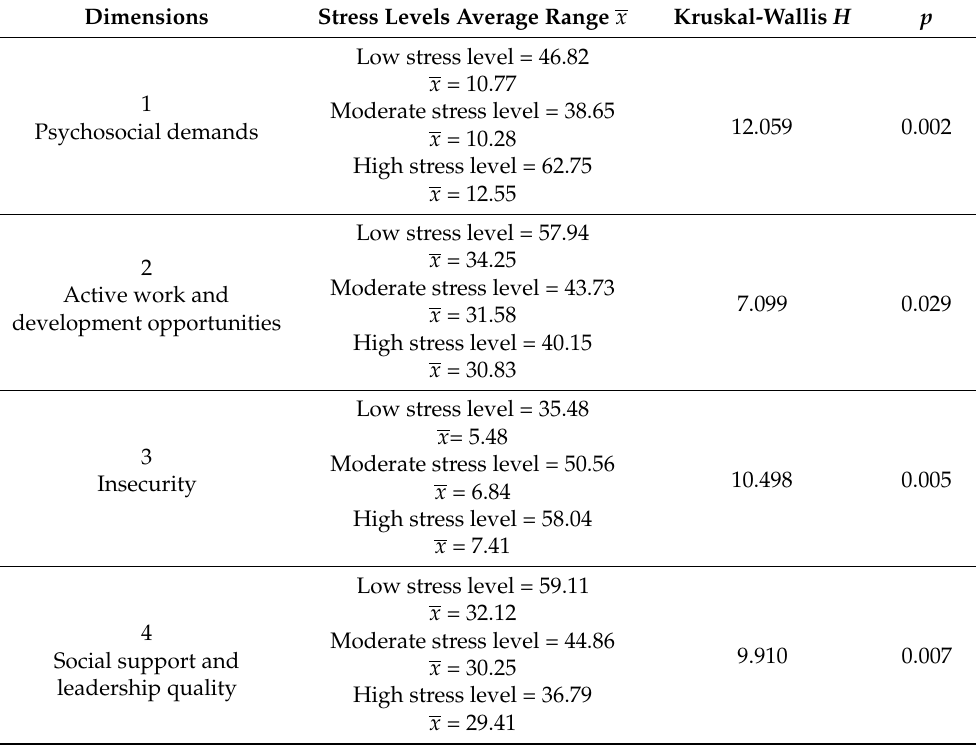
Table 6. Relationship between the components of the Psychosocial Risk Assessment Questionnaire in Non-Formal Settings and Stress